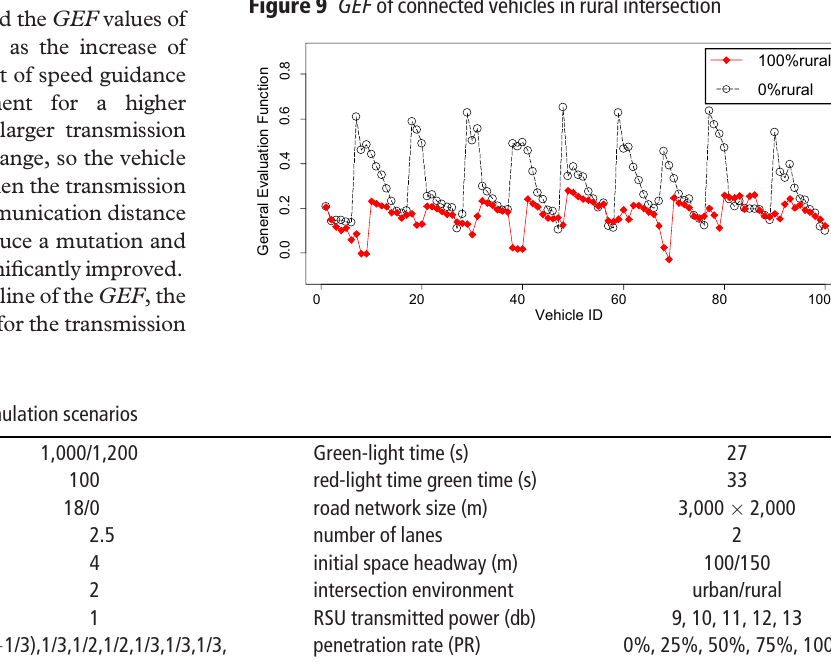
Figure 9 GEF of connected vehicles in rural